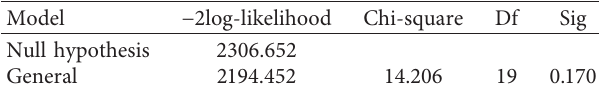
Table 4: Multicollinearity test